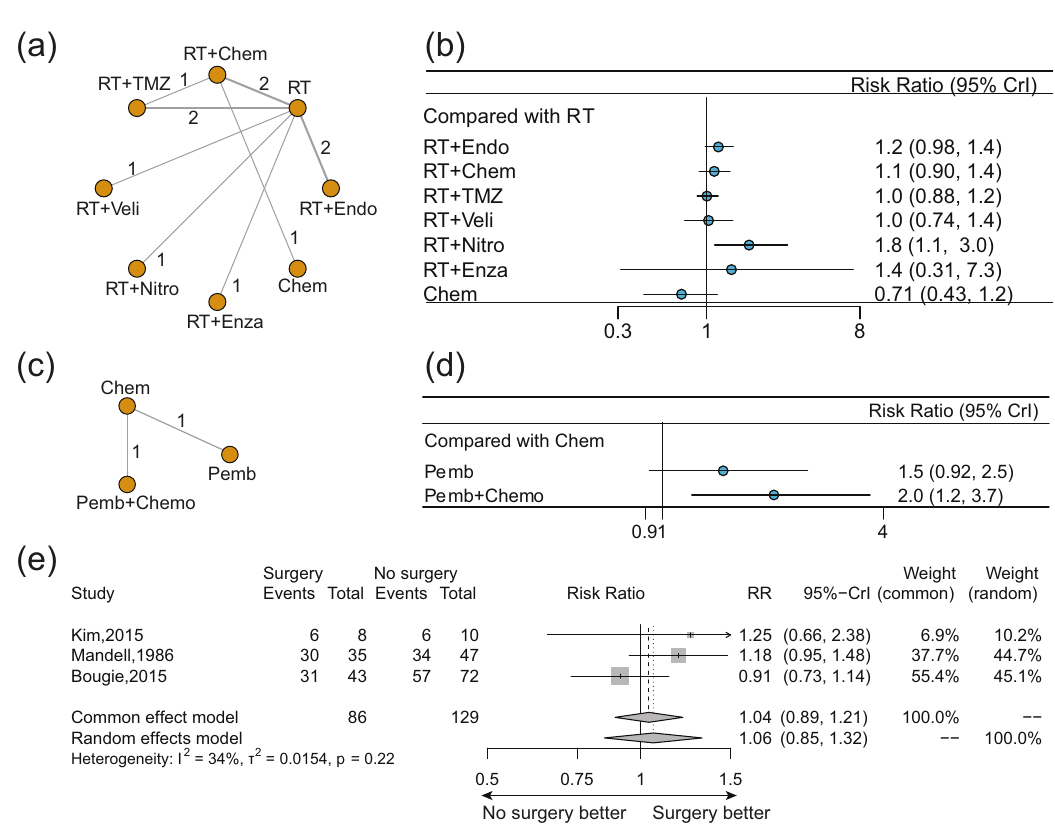
Figure 4: Pooled result of ORR for di ff erent treatments for BMs from EGFR/ALK - negative/unselected NSCLC. ( a ) Network diagram and ( b ) forest plot of ORR for di ff erent treatments compared with radiotherapy alone in newly diagnosed BMs. ( c ) Network diagrams and ( d ) forest plot of ORR for di ff erent treatments compared with chemotherapy alone in previously treated BMs. ( e ) Forest plot of ORR comparing surgery with radiotherapy alone. Each node in the network diagram represents one treatment, and the numbers represent direct head - to - head comparisons. Abbreviations: RT, radiotherapy; TMZ, temozolomide; Chem, chemotherapy; Endo, endostatin; Enza, enzas